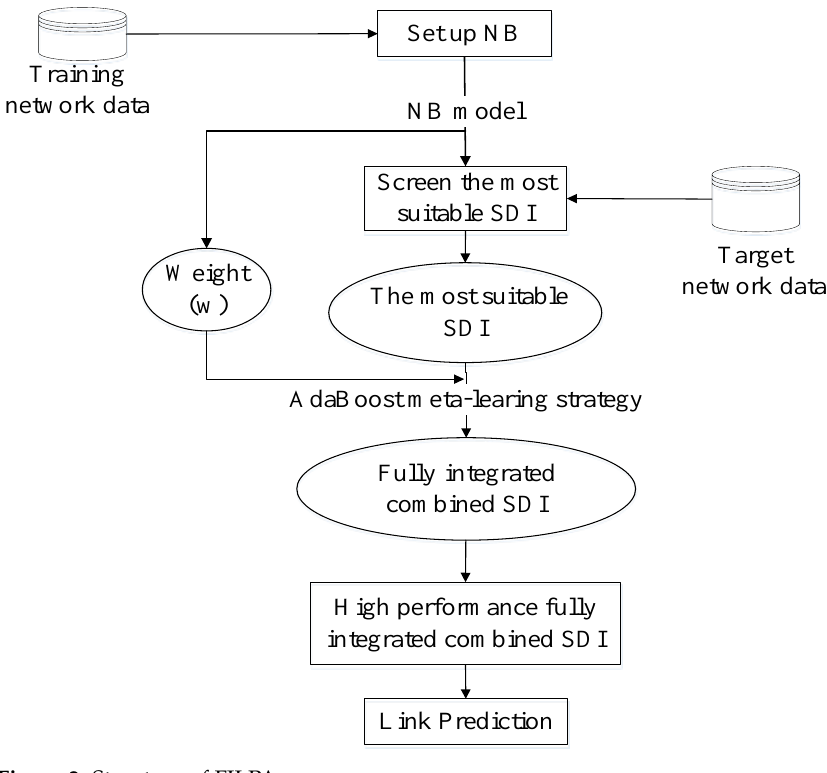
Figure 2. Structure of FILPA.